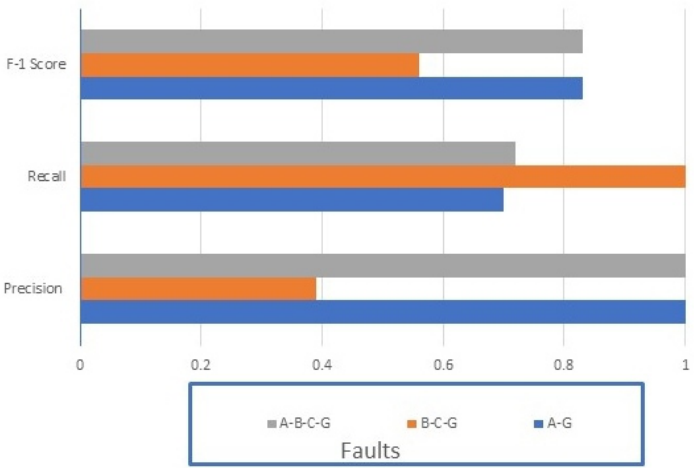
Figure 8. Performance of the different faults